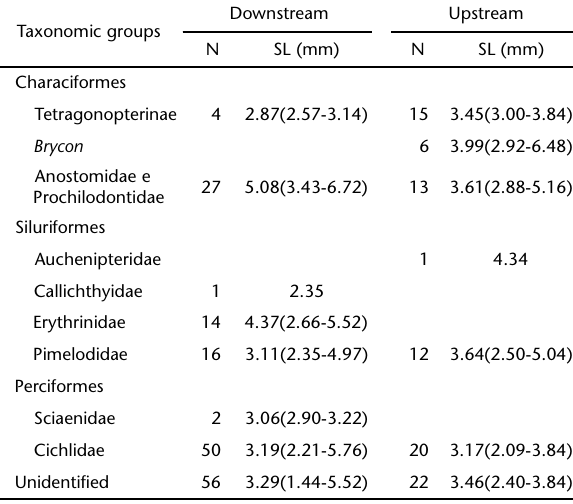
Table II. Mean (amplitude) standard length (SL) for each taxonomic group in the two samples. Taxonomic